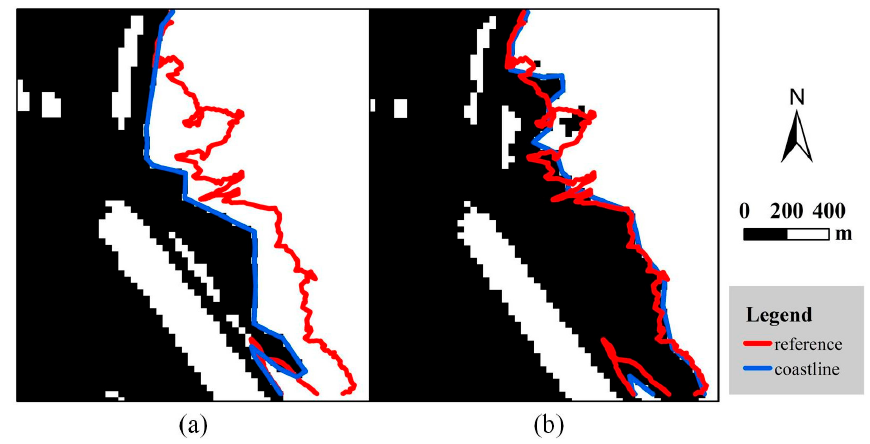
Figure 12. Positions of reference coastline (red line) and extracted coastline (blue line) from 30 m resolution Landsat image. Coastline in ( a ) extracted using 0 as the threshold, while Otsu method was used to obtain the optimal threshold in ( b ).